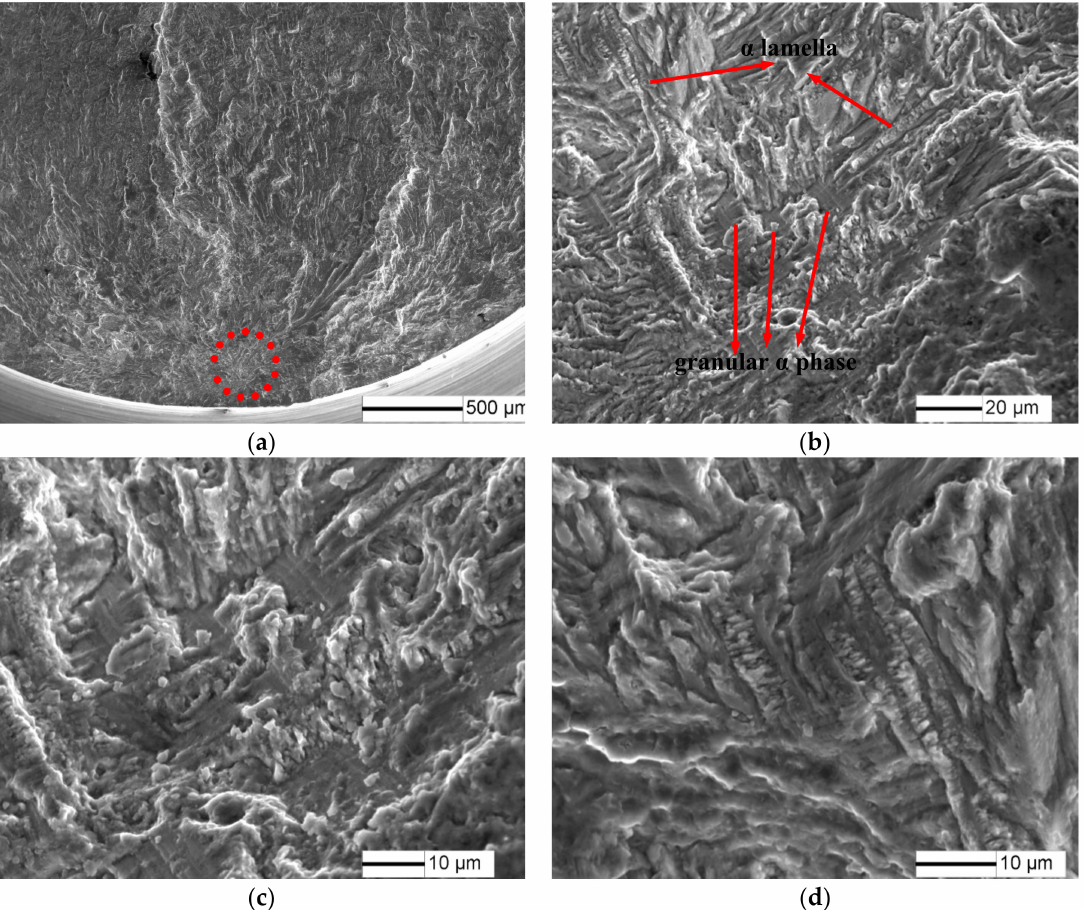
Figure 10. Fracture surface for the notch specimens at σ = 300 MPa and N = 2 × 10 7 cycles: ( a ) fatigue crack initiation site (remarked by red line), ( b ) crack initiation morphology, ( c ) flat facet morphology, and ( d ) distribution of fine grains on the α